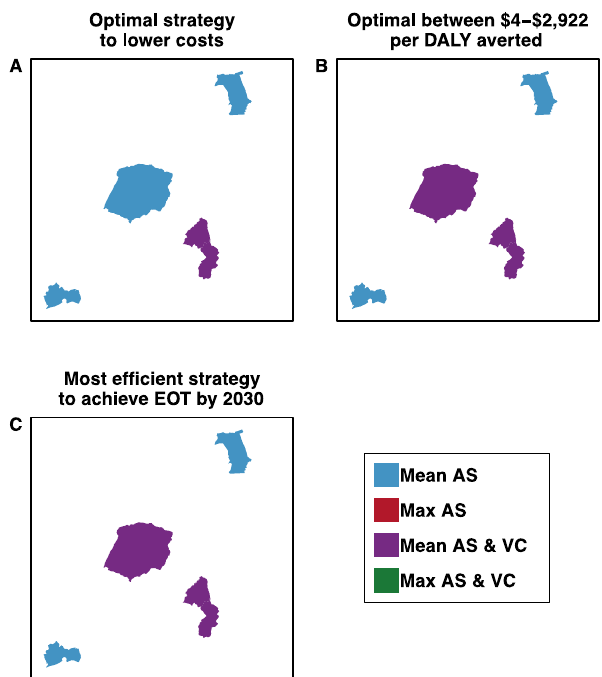
Fig. 4 Maps of preferred strategies according to economic or budgetary goals for 2020 – 2040. Maps ( A ) & ( B ) show the optimal strategies depending on willingness-to-pay (WTP). The text indicates the probability that the optimal strategy will lead to elimination of transmission (EOT) by 2030. Map ( C ) shows the optimal strategy that has at > 90% probability of EOT by 2030 and shows the incremental cost-effectiveness ratio (ICER) of the indicated strategy (Mean AS for all locations except Yasa Bonga, where it is Mean AS & VC). Maps are not drawn to scale. Maps with time